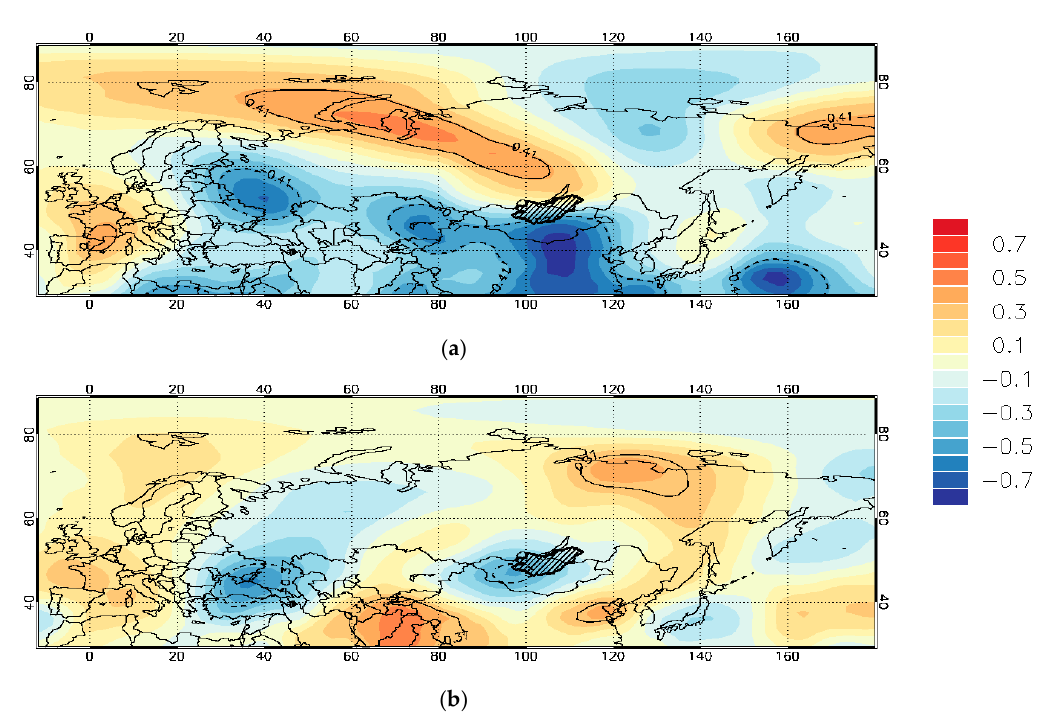
Figure 15. Correlation coefficients of TMPS and Z500 for 1979–1995 ( a ) and 1996–2016 ( b ). The Figure description is the same as in Figure 8.